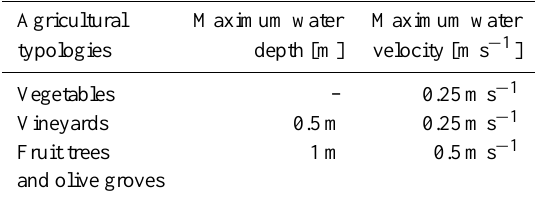
Table 3. Thresholds for flood hazard metrics for different agri- cultural typologies, in the spring, summer and autumn seasons (adapted from Citeau, 2003).